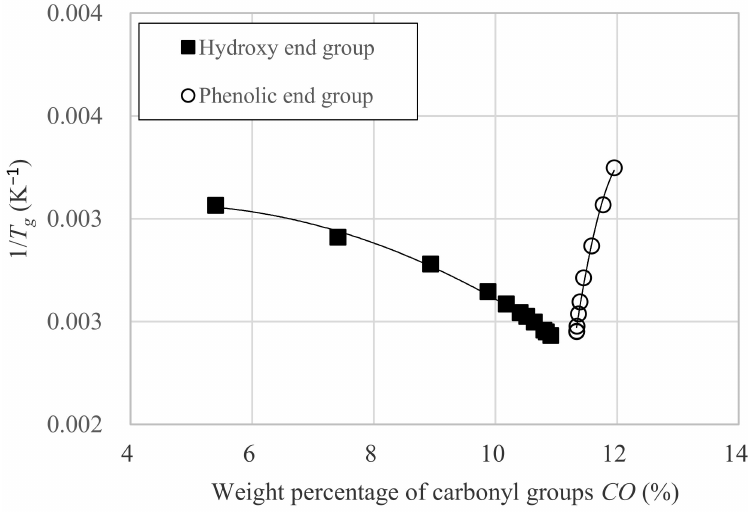
Figure 11. Relation between the weight percentage of carbonyl groups CO and the inverse number of T